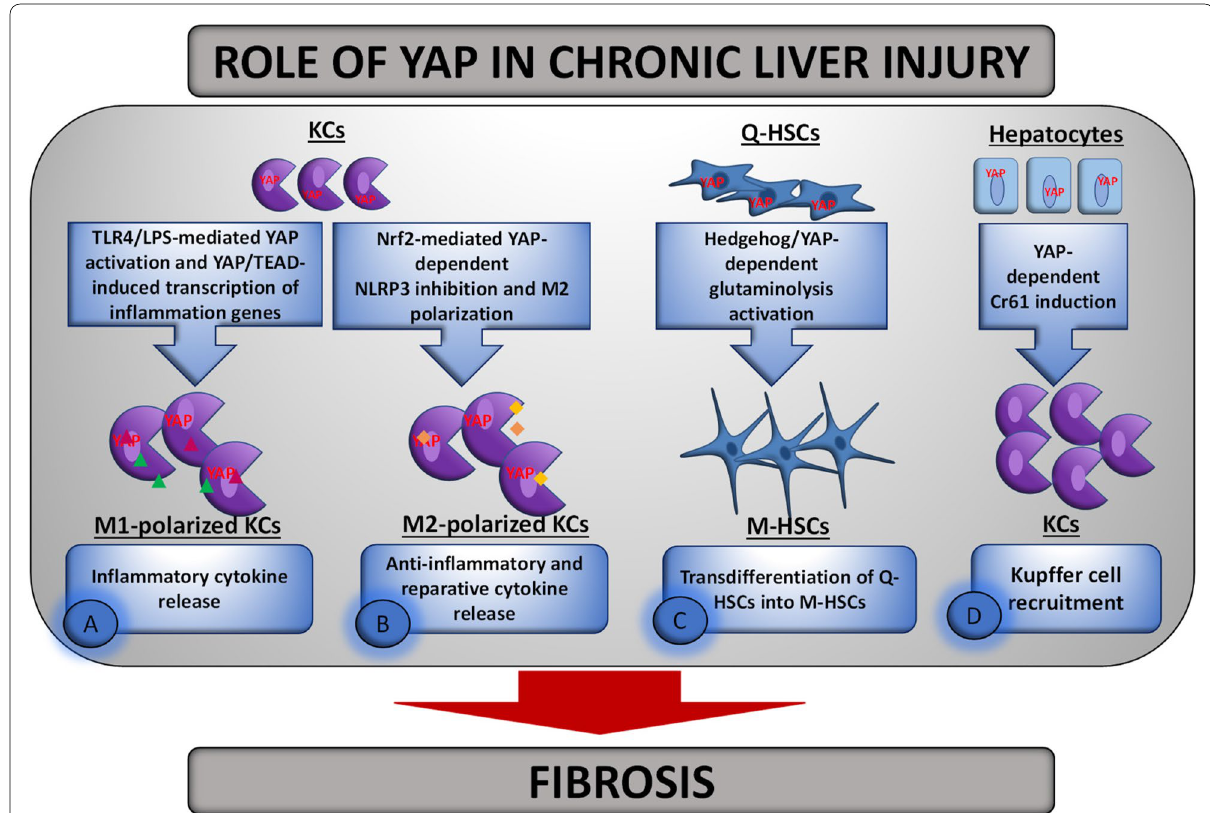
Fig. 5 Schematic representation of the role of YAP/TAZ in chronic injured liver. YAP activation in chronically injured liver leads to a wound healing response characterized by ( A ) YAP/TEAD mediated transcriptional activation of inflammatory genes in KCs leading to the release of inflammatory cytokines; ( B ) inhibition of NLRP3 inflammasome and induction of M2 polarization in KCs, accompanied by the release of anti-inflammatory and reparative cytokines; ( C ) trans-differentiation of Q-HSCs to M-HSCs, which is due to Hedgehog/ YAP-mediated stimulation of glutaminolysis in Q-HSCs; and ( D ) induction of Cyr61 expression in hepatocytes, which promotes macrophage